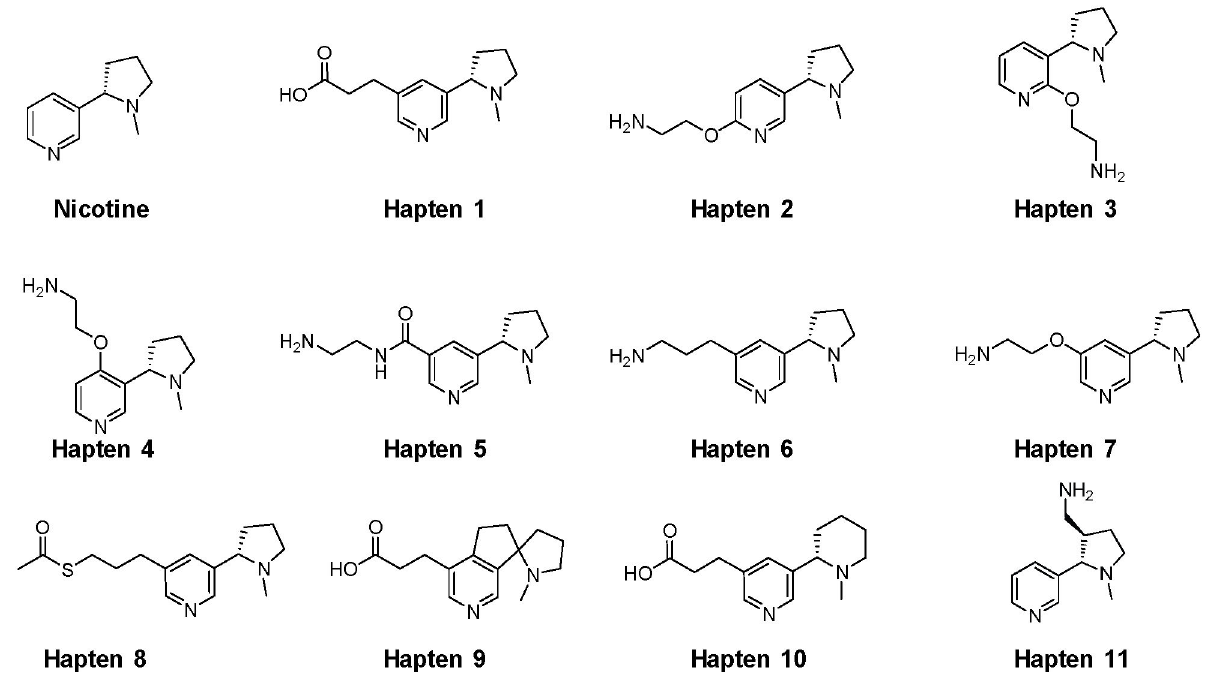
Figure 1. Nicotine and hapten structures. The thioacetate of Hapten 8 was deprotected to the thiol for coupling with DT. doi: